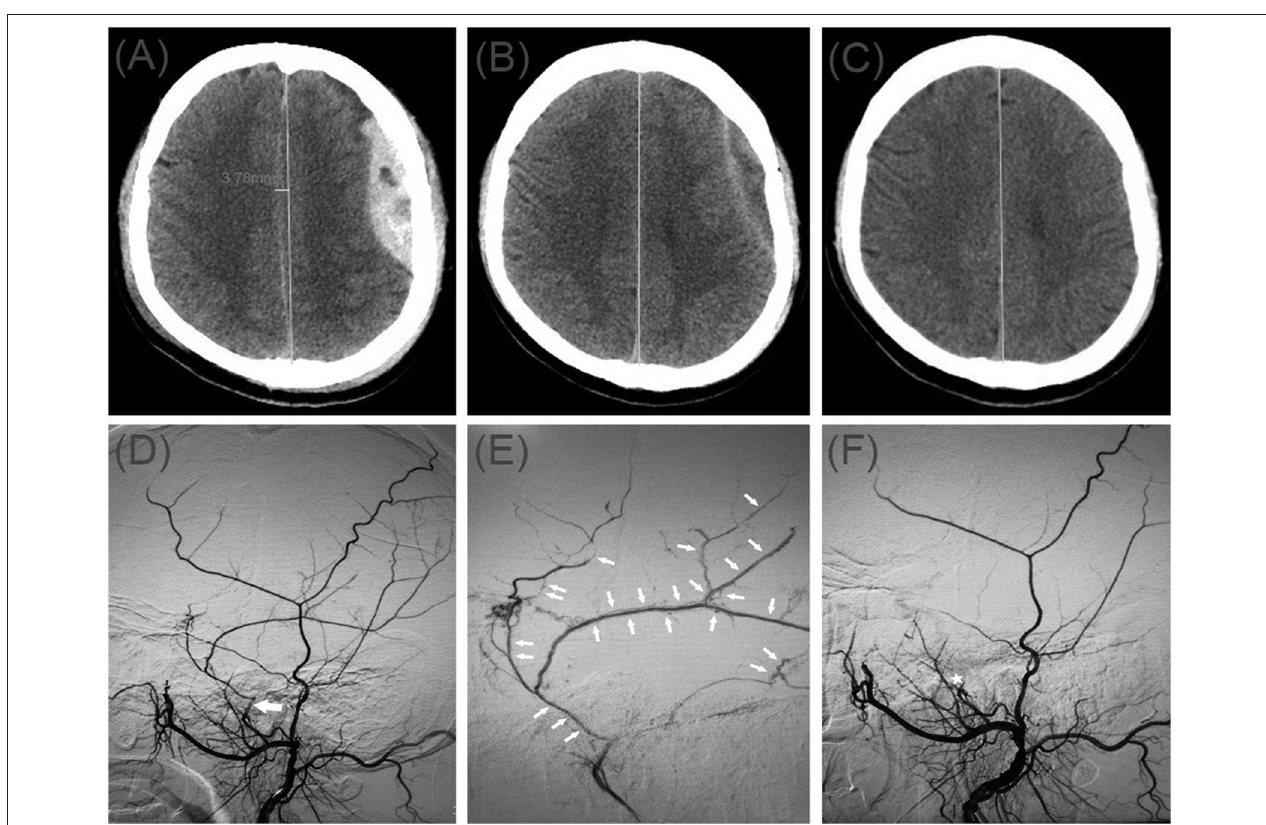
FIGURE 2 | (A) Brain computed tomographic hematoma images for patient 2 before treatment (midline shift: 3.78mm). (B) Brain CT was repeated on postoperative day 10. (C) Follow-up brain CT was performed at 67 days. (D) Pre-operative DSA presented abnormal MMA (Large arrow). (E) Intra-operative DSA showed contrast agent extravasation or arteriovenous fistula (Small arrow). (F) Postoperative DSA found that the MMA disappeared